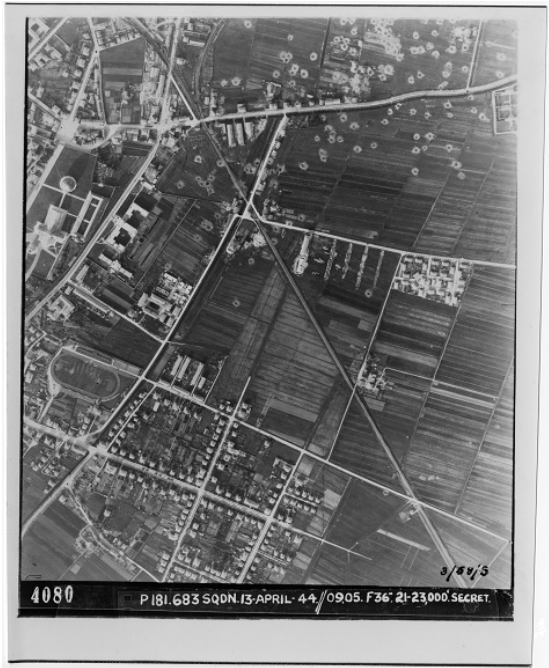
Figure 4. A digitized RAF photo, with information about the flight at the bottom: It was taken at 9:05 AM on 13 April 1944, from an altitude of 21–23,000 feet, with a camera having a focal length of 36 inches. The negative has the progressive number 4080. The famous leaning tower of Pisa and the Duomo are visible on the left ( c (cid:13) MiBAC-ICCD, Aerofototeca Nazionale, fondo